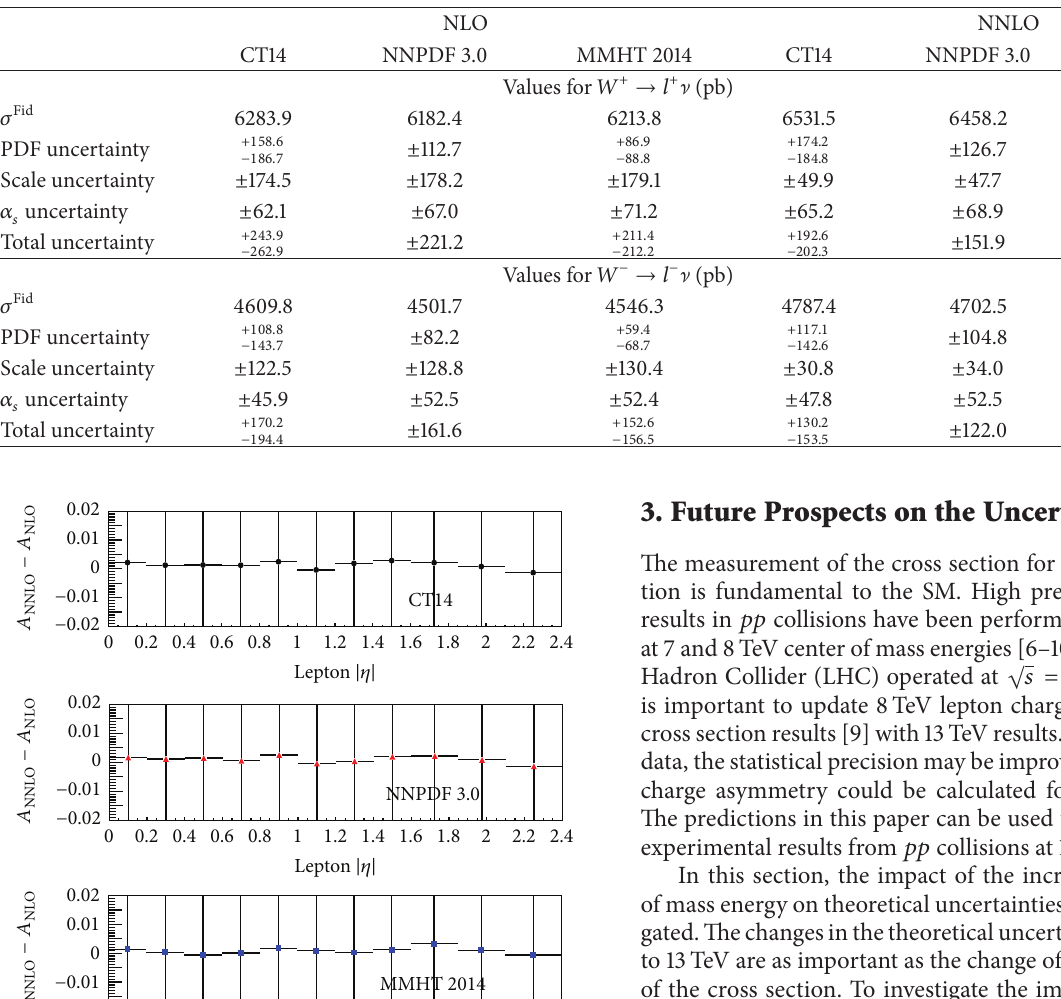
Table 1: Predicted fiducial cross section numbers with NLO and NNLO QCD corrections at √𝑠 = 13 TeV. All numbers are in units of pb.